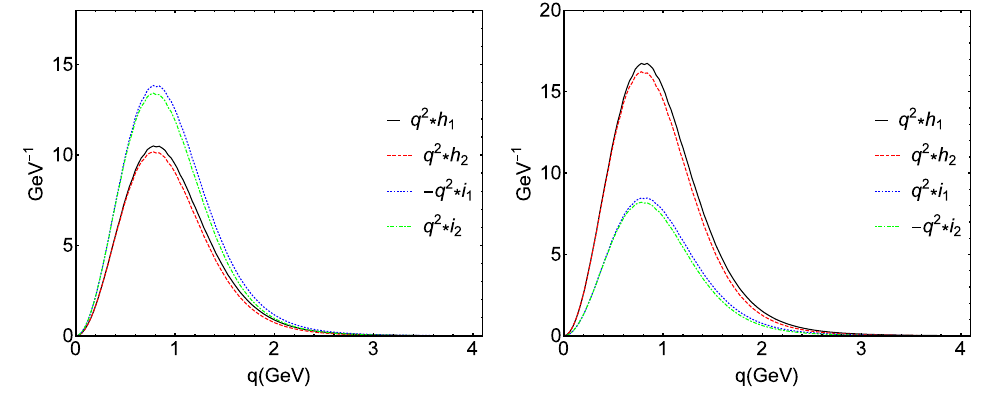
Figure 8 . The 2 − wave functions of the 1 1 D 2 − 1 3 D 2 mixing states B c 2 (1 D ) (left) and B 0 (right). h 1 and h 2 terms are 1 D 2 waves; i 1 and i 2 terms are 3 D 2 waves.